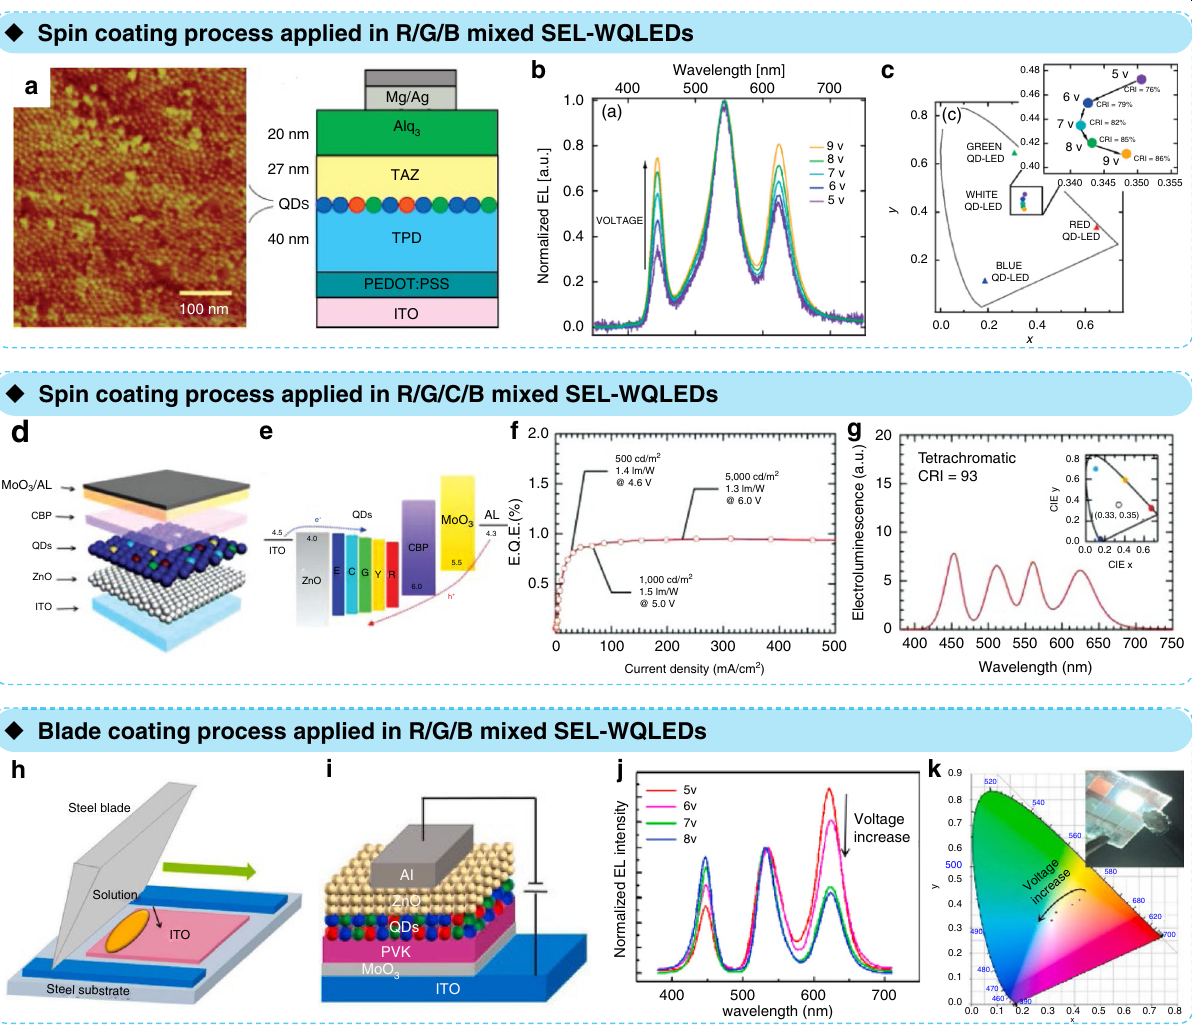
Fig. 7 Mixing multi-colour QDs as a monolayer for SEL-WQLEDs. a Atomic force microscopy phase image of blue QDs forming approximately 1.1 monolayers on top of a 40-nm-thick TPD fi lm and device cross section of a white QD – LED. b Normalised EL spectra of a white QD – LED for a set of increasing applied voltages. The relative intensities of the red and blue QD spectral components increase in comparison to the green QD component at higher biases. c CIE coordinates with the red, green, and blue QD – LEDs (triangles). The circle symbols show the evolution of the CIE coordinates and CRI of the white QD – LEDs upon increasing the applied bias. Reprinted with permission from ref. 25 . Copyright 2007 American Chemical Society. d Device architecture and e energy-band diagram of white QLEDs with an inverted device structure of ITO/ZnO nanoparticle fi lms (50 nm)/mixed QD-active layers/CBP (40 nm)/MoO 3 (10 nm)/Al (100 nm). ZnO and QD layers were prepared by spin-casting, and CBP, MoO 3 , and Al were thermally evaporated on top of the spin-cast ZnO/QD layers. f EQE and g EL spectra of tetrachromatic (B + C + Y + R) white QLEDs. The brightness, power ef fi ciency, and applied voltage of white QLEDs at brightness levels of 500, 1000, and 5000 cd m − 2 are also indicated on EQE vs. J graphs. The CIE coordinate is displayed in the inset. Reprinted with permission from ref. 22 . Copyright 2014 WILEY-VCH Verlag GmbH & Co. KGaA, Weinheim. h Schematic illustrating the experimental setup by blade coating. i Structure-mechanism diagram of WQLEDs. j Normalised EL spectra of white QLEDs at various voltages. k CIE coordinates of the device at various voltages; the inset is a photograph of the luminous white QLED at 8 V. Reprinted with permission from ref. 24 . Copyright 2020